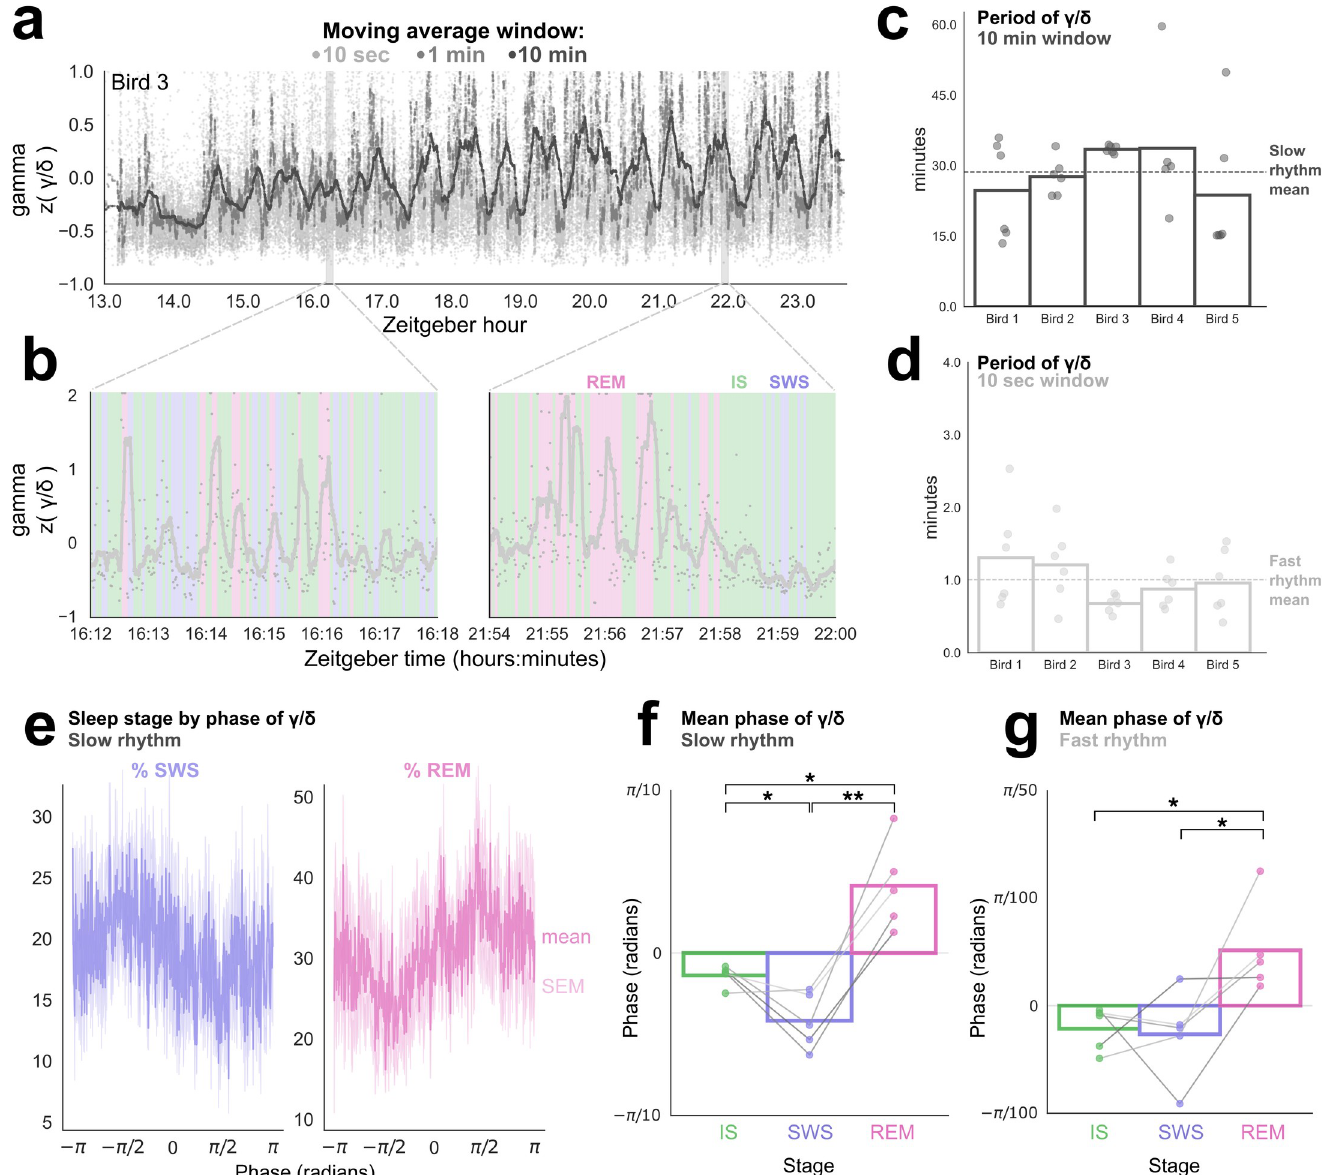
Fig 6. Characterizing ultradian rhythms in sleep. (a) The gamma/delta ratio across the night (Bird 3). Moving averages with 3 different window lengths revealed underlying oscillations in the gamma/delta ratio. The slow rhythm cycles approximately every 30 min. Shaded areas correspond to 6-min windows displayed in (b). Each dot indicates one 1-s epoch. (b) The gamma/delta ratio in two 6-min windows as indicated in (a). Very light grey dots correspond to raw data. The solid grey line shows the 10-s moving average. This bird’s fast rhythm had a period of approximately 40 s, or 9 cycles per 6 min. Note the tendency for different sleep cycles (colors) to segregate at different phases of the fast cycle. (c) The period for the gamma/delta ratio of the 10-min moving average. Each dot represents a single EEG channel. Each bar represents an individual bird. Mean of birds (dashed line) was 28.66 min ± 4.2 min. (d) Same as (c) for 10-s moving average; mean = 60.37 s ± 13.71. (e) The percent of SWS epochs (left) and percent of REM epochs (right) at each phase of the slow rhythm. The data were fitted to a sinusoid with a trough at - π /2 and a peak at π /2. Dark line shows the mean across birds; light shading indicates the SEM. (f–g) The average phase at which each epoch of a given stage occurs for the slow rhythm (f) and the fast rhythm (g) in the gamma/delta ratio. Each dot represents an individual bird. Each bar indicates the mean across all birds. Lines are colored according to bird identity, from Bird 1 (darkest lines) to Bird 5 (lightest). � p < 0.05, �� p < 0.01, paired t tests. Data are provided in S1 Data. EEG, electroencephalogram; IS, intermediate sleep; REM, rapid eye movement sleep; SWS, slow wave sleep.